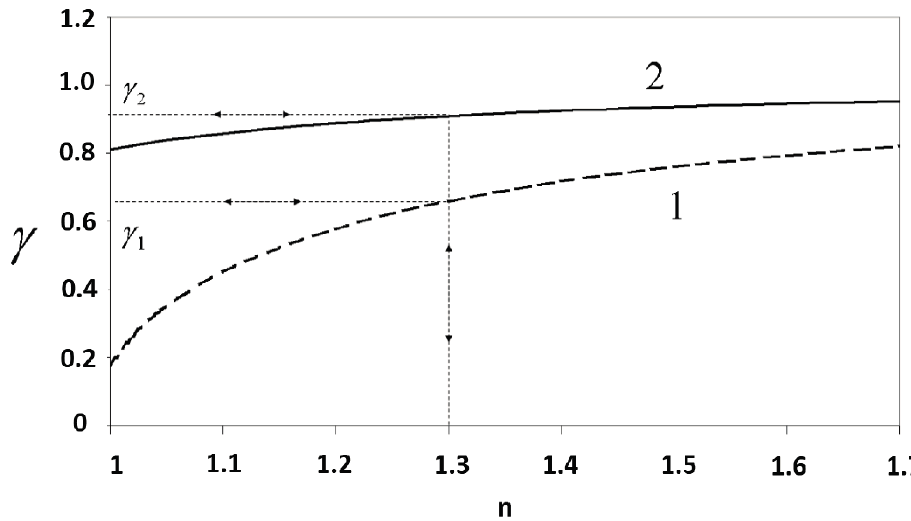
Figure 12. γ as a function of n for two different angle of incidence pairs: Curve 1: 10° and 80°; Curve 2: 33° and 47°.